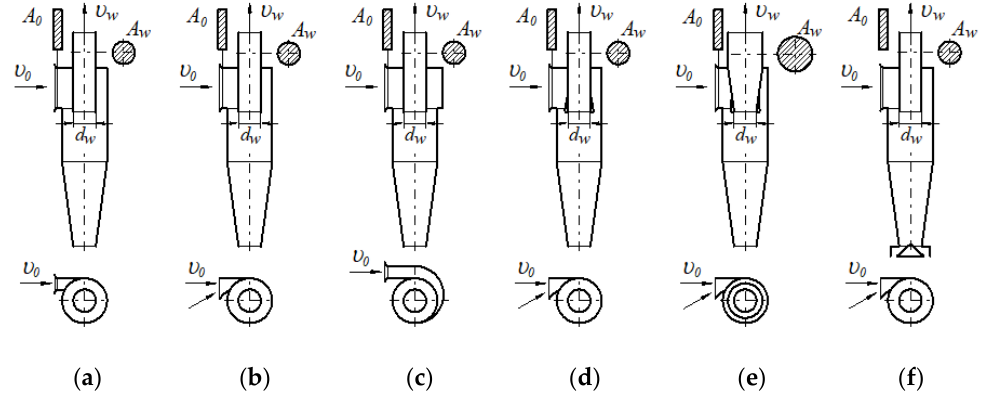
Figure 24. Possible changes in the design of cyclone D- 40: ( a ) original version, ( b ) changing the shape of the inlet from symmetrical to asymmetrical, ( c ) using a spiral inlet described on the